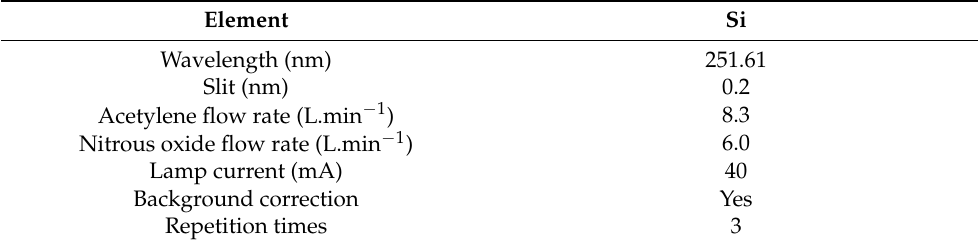
Table 1. Atomic absorption spectrometer measuring conditions.